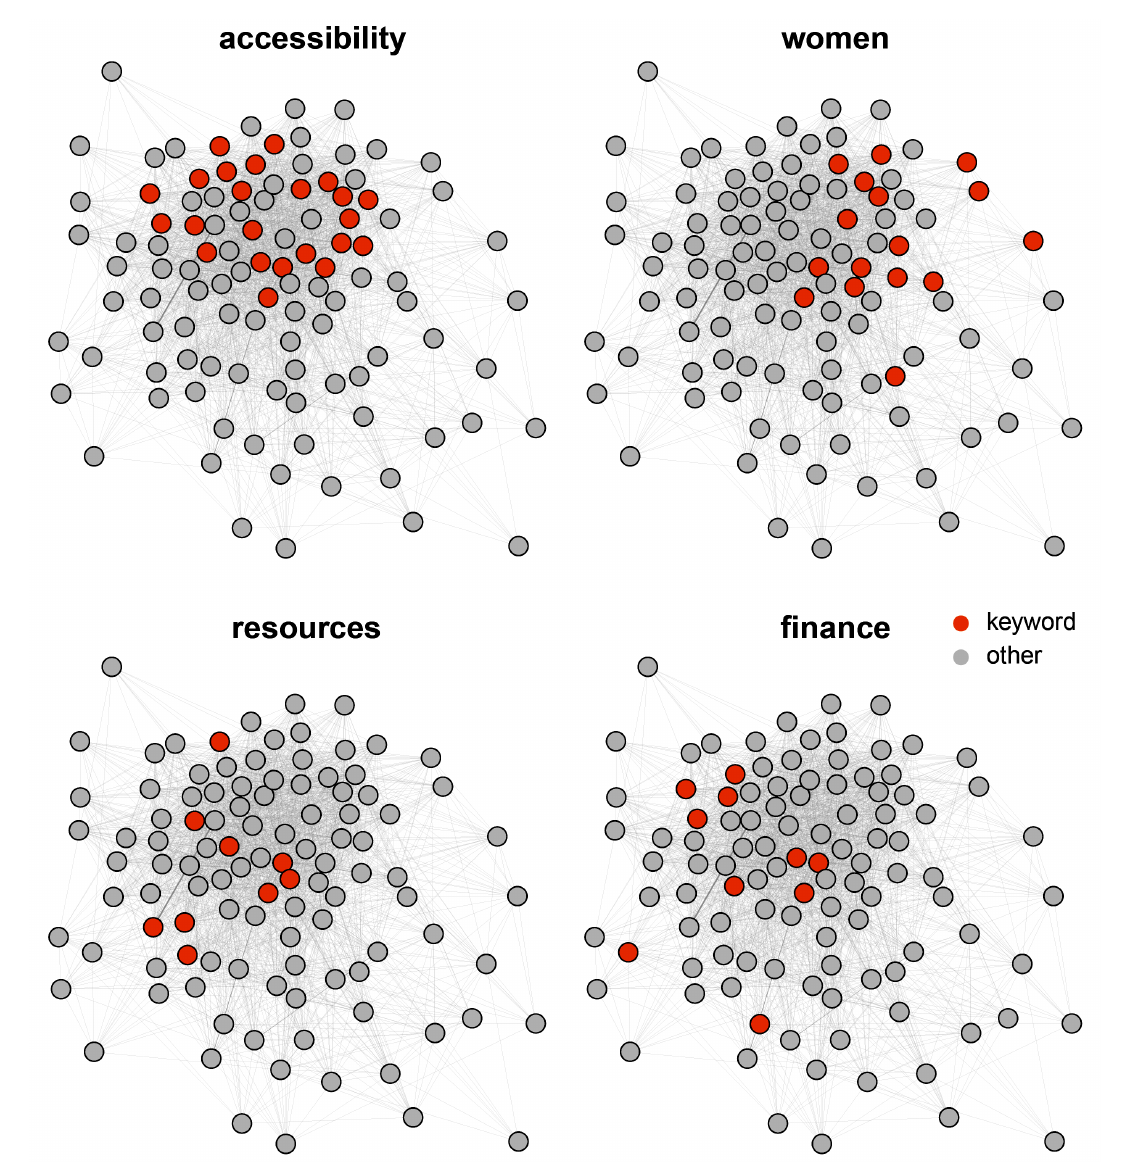
Fig. 3. A network of 107 SDG targets connected by shared challenges, subjects, instruments, conditions, actions, and properties. Targets containing a selected subset of keywords that occur across many goals are highlighted in orange, other targets are illustrated in